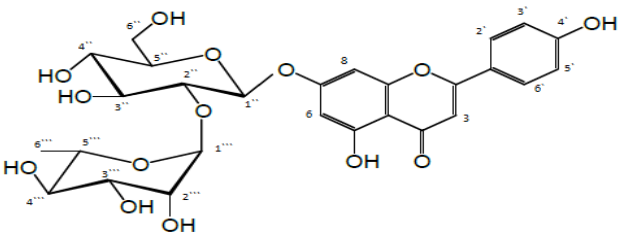
Figure 1. Chemical structure of rhoifolin (apigenin 7-O- β neohesperidoside).